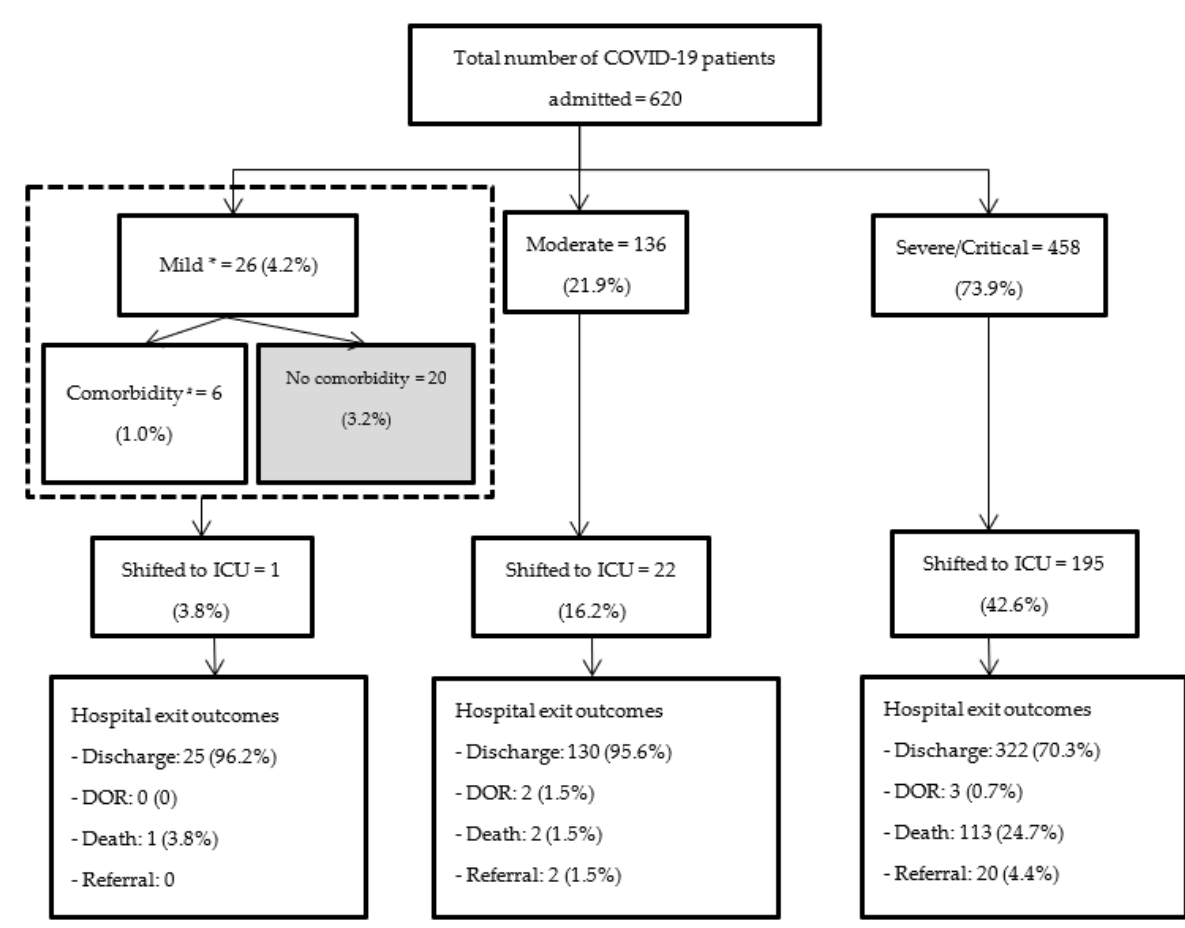
Figure 1. Severity at admission, shift to ICU and hospital exit outcomes among COVID-19 patients admitted in a tertiary teaching hospital of Nepal during April to September 2021. * Severity is categorized according to WHO clinical living guideline; # Comorbidities include diabetes, hypertension, chronic kidney disease, hypothyroidism, known cardiac disease; Except for mild cases without comorbidity, all the others were eligible for admission. Abbreviations: ICU—Intensive Care Unit; DOR—Discharge on